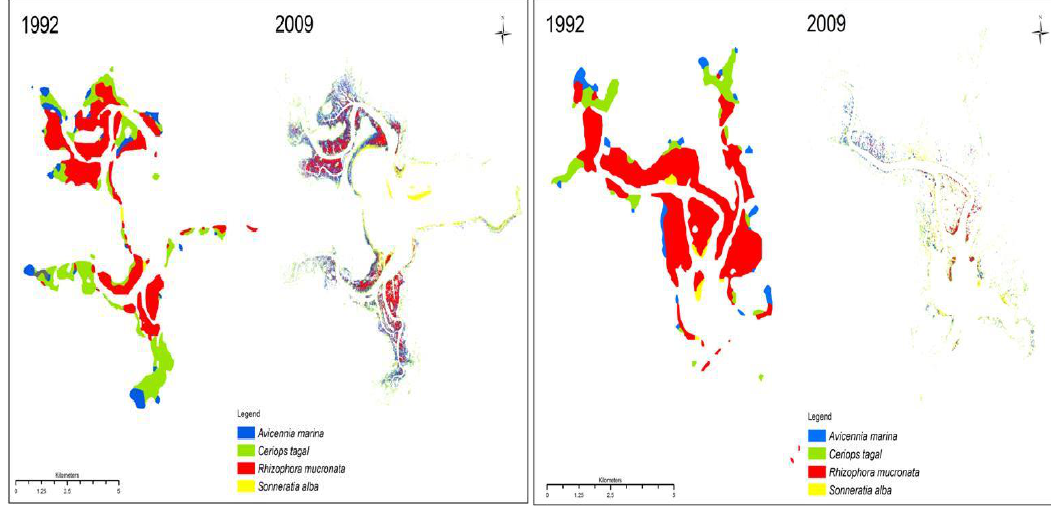
Figure 6: Species shift between 1992 and 2009 in Mwache and Tudor creeks, respectively 23